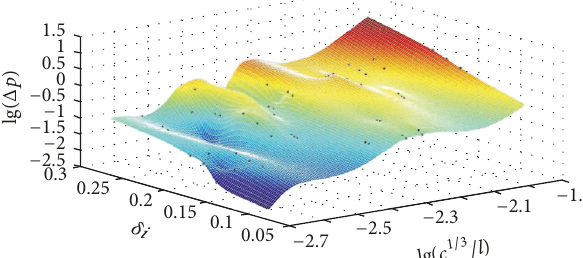
Figure 6: Mountain surface and scatter figure of the shock wave peak